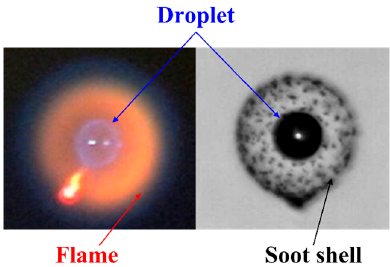
Figure 3. Formation of a soot shell around a burning droplet.